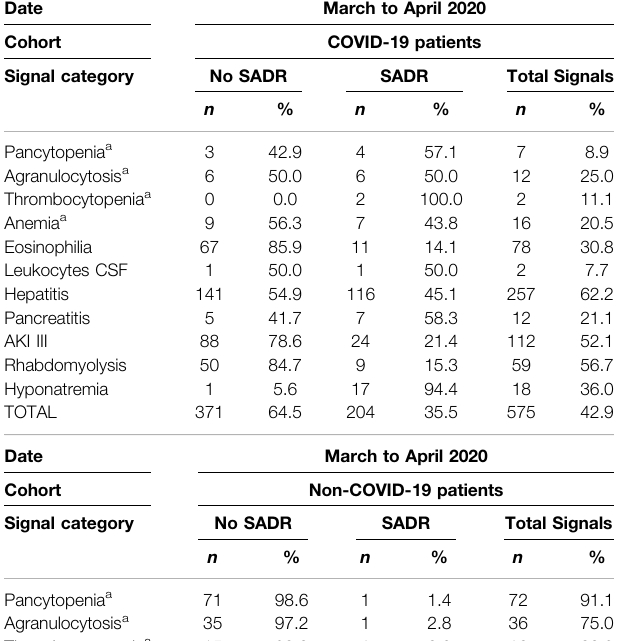
TABLE 3 | Incidence rate (Poisson 95% CI) per 10,000 patients of no SADR vs. SADR recorded from March to April 2020 in COVID-19 patients vs. non- COVID-19